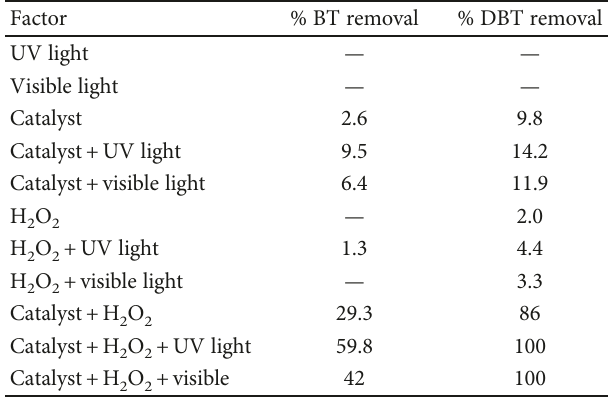
Table 5: % BT and DBT removal in di ff erent condition after 20min.